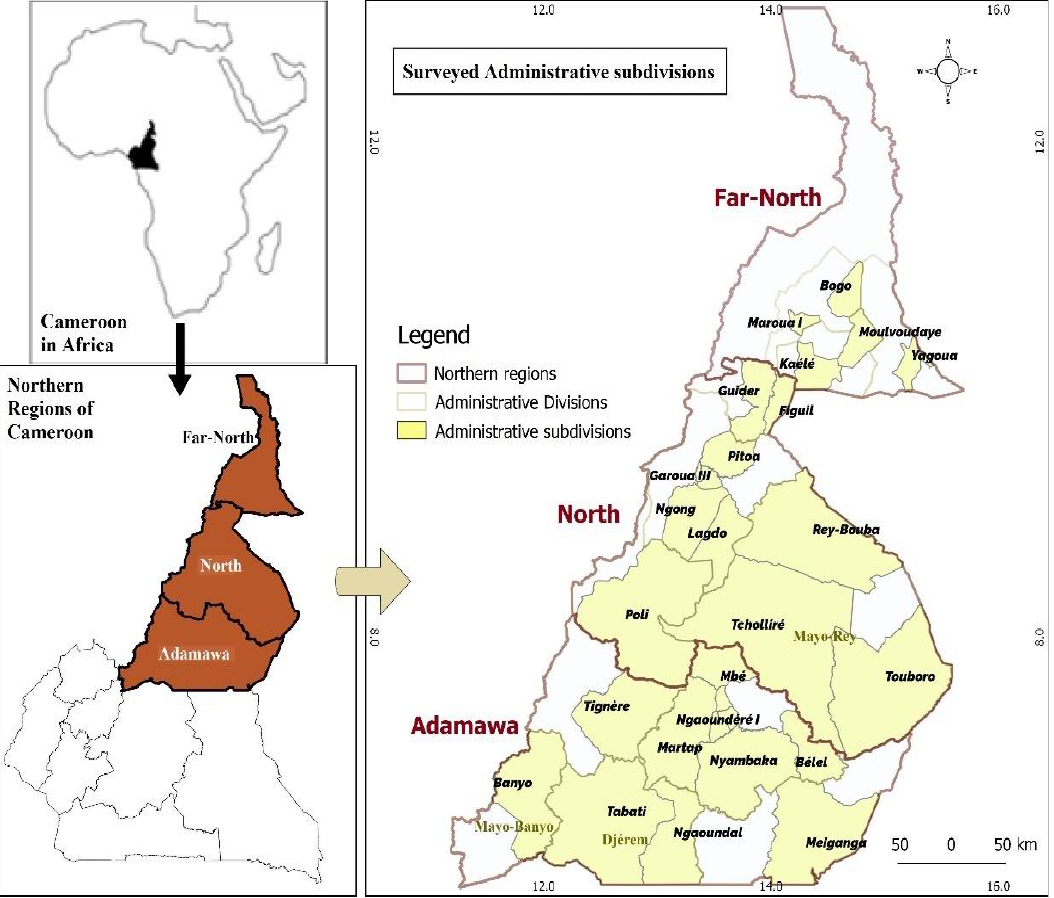
Figure 1. Map of study area.